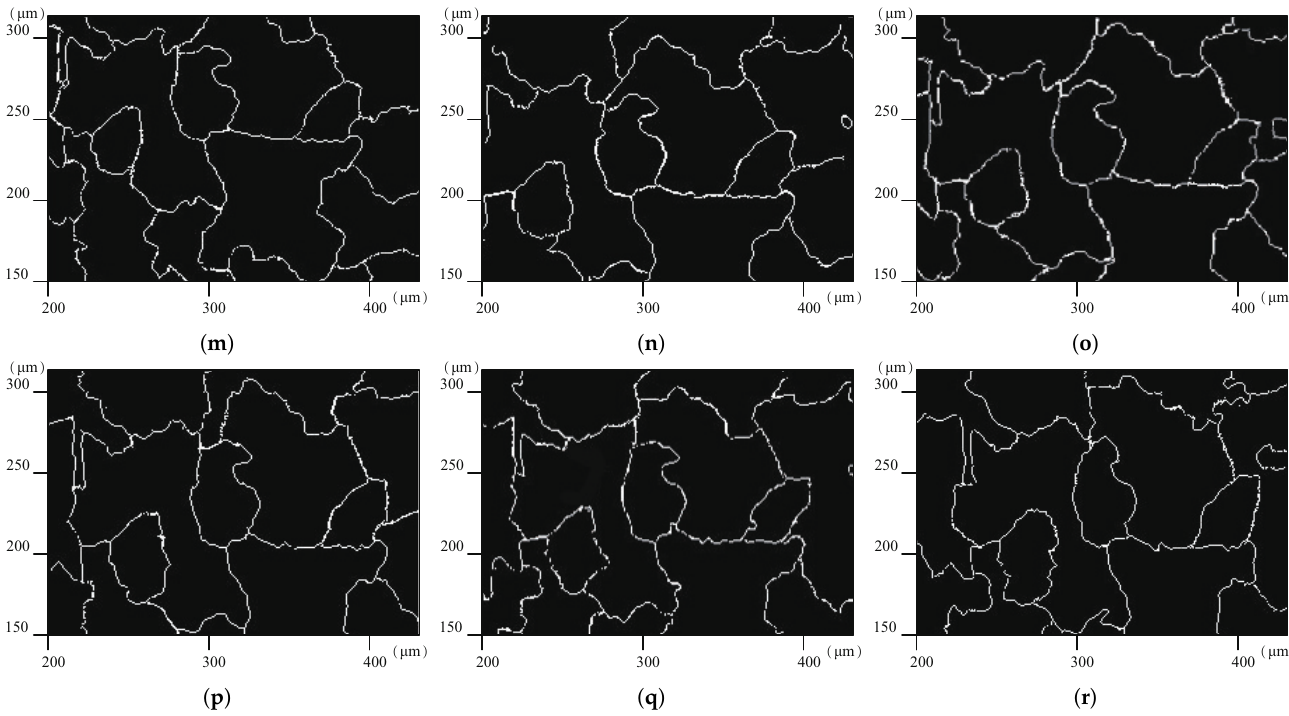
Figure 9. The grain boundary observed under monotonically increasing tensile loading F: ( a ) F = 0 N;